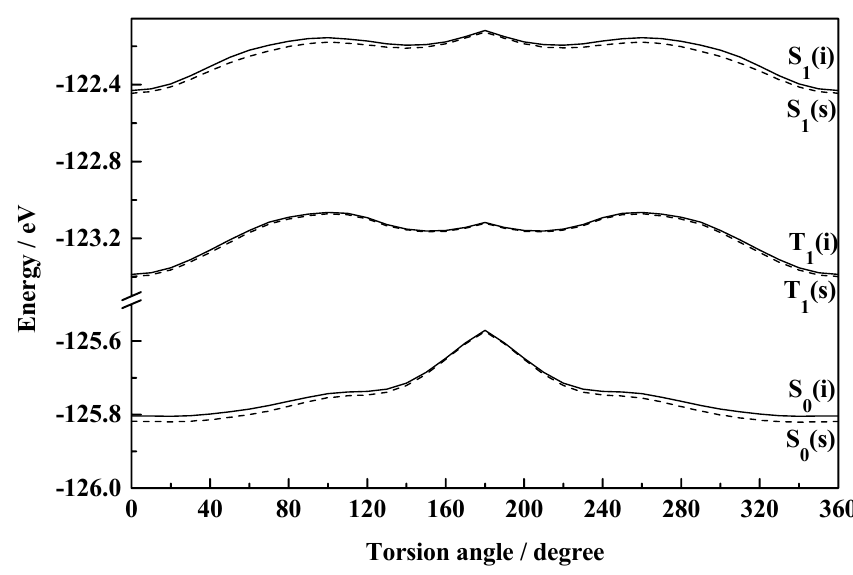
Figure 1. Plot of total molecular energy as a function of torsional angle (7-8-10-11) in S states of HBO (i, isolated; s, solvated in ethanol).